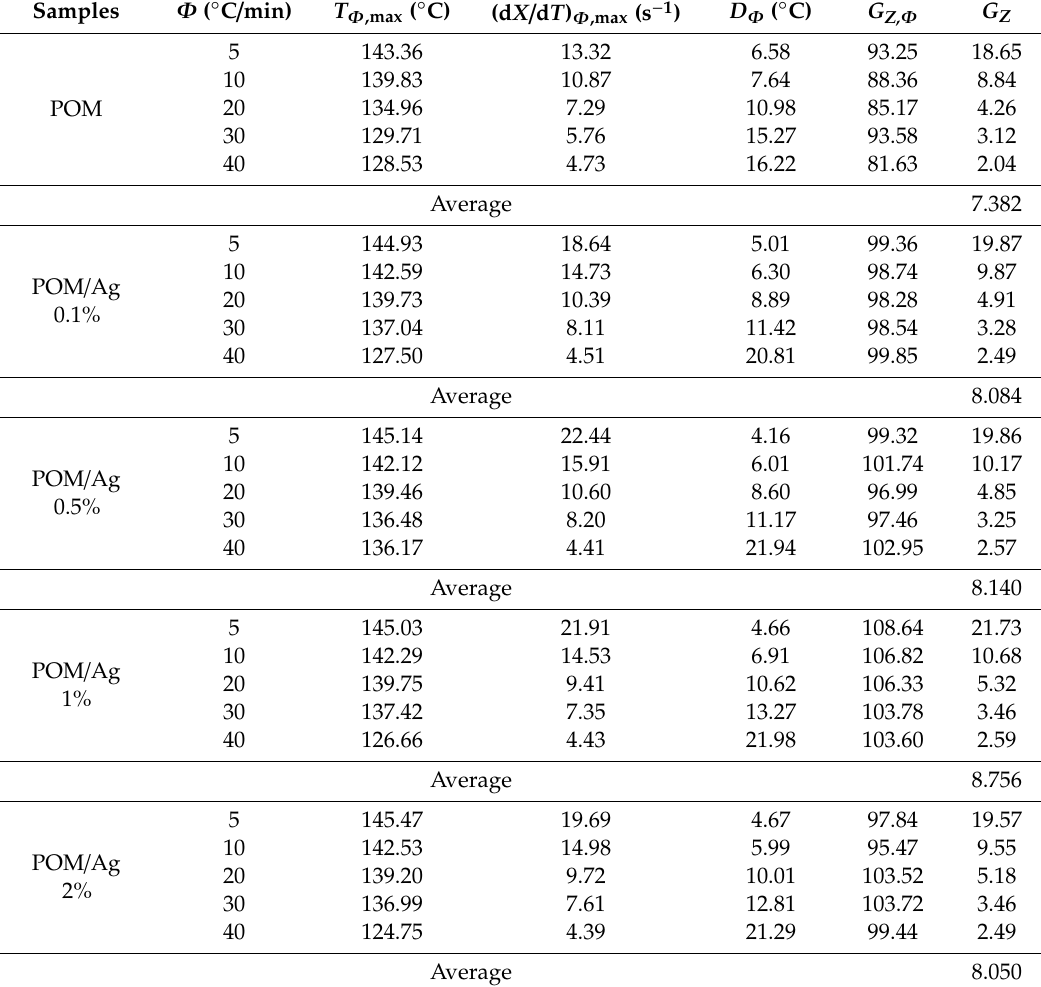
Table 5. Parameters of Ziabicki analysis for the POM / Ag